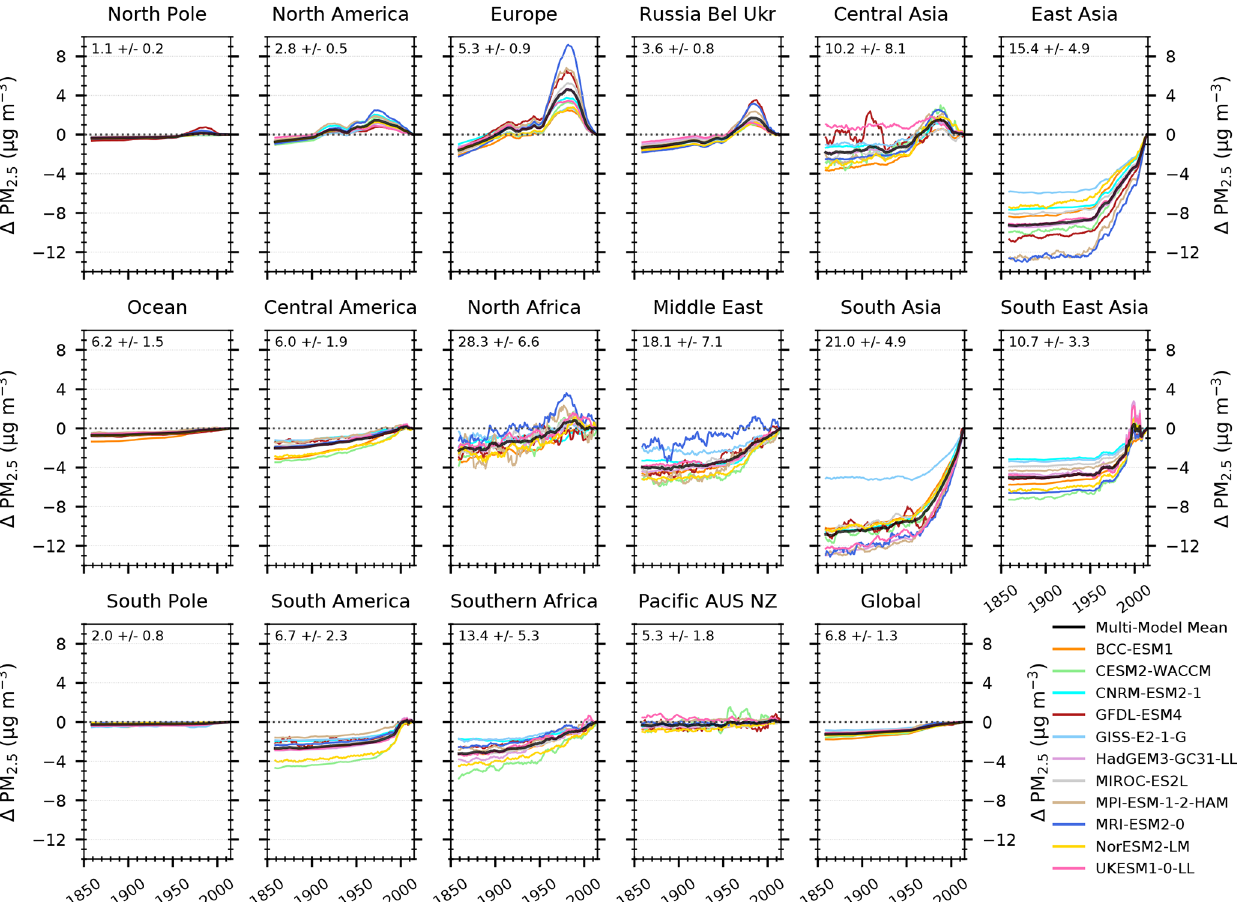
Figure 10. Changes in the regional and global annual mean surface PM 2 . 5 concentrations, relative to a 2005–2014 mean value, across 11 CMIP6 models. Changes for each region are computed as 10-year running means over the historical period. The multi-model mean 2005– 2014 surface PM 2 . 5 concentrations ( ± 1SD) are shown in the top left of each panel. Regions are defined in Fig.